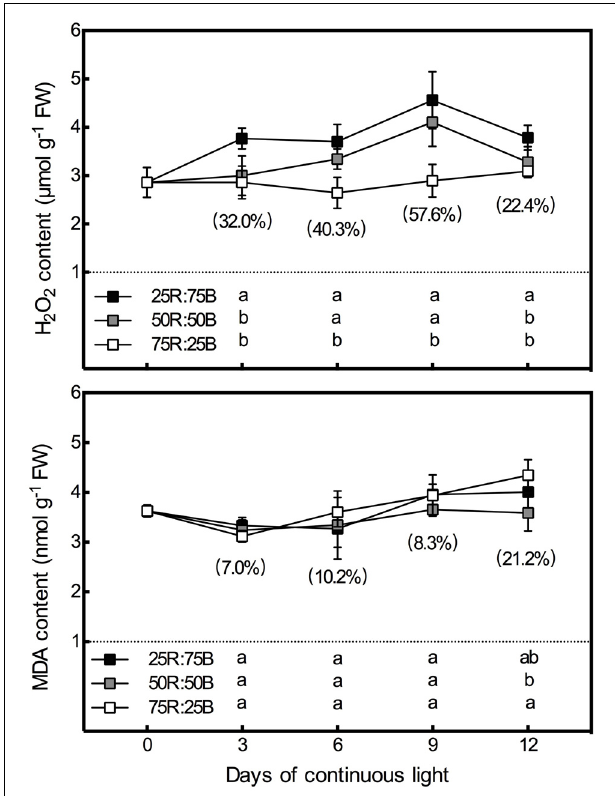
FIGURE 5 | Effects of the red:blue light ratio on the H 2 O 2 and MDA contents in lettuce leaves under continuous light (200 µ mol · m – 2 · s – 1 ) (200 µ mol · m – 2 · s – 1 ). Data are the mean values ± SD of four replications. Different letters indicate significant differences between different red:blue light ratio treatments at p < 0.05 according to Tukey test. Data in brackets were the increasing rate of the maximum value to the minimum value on the same day.